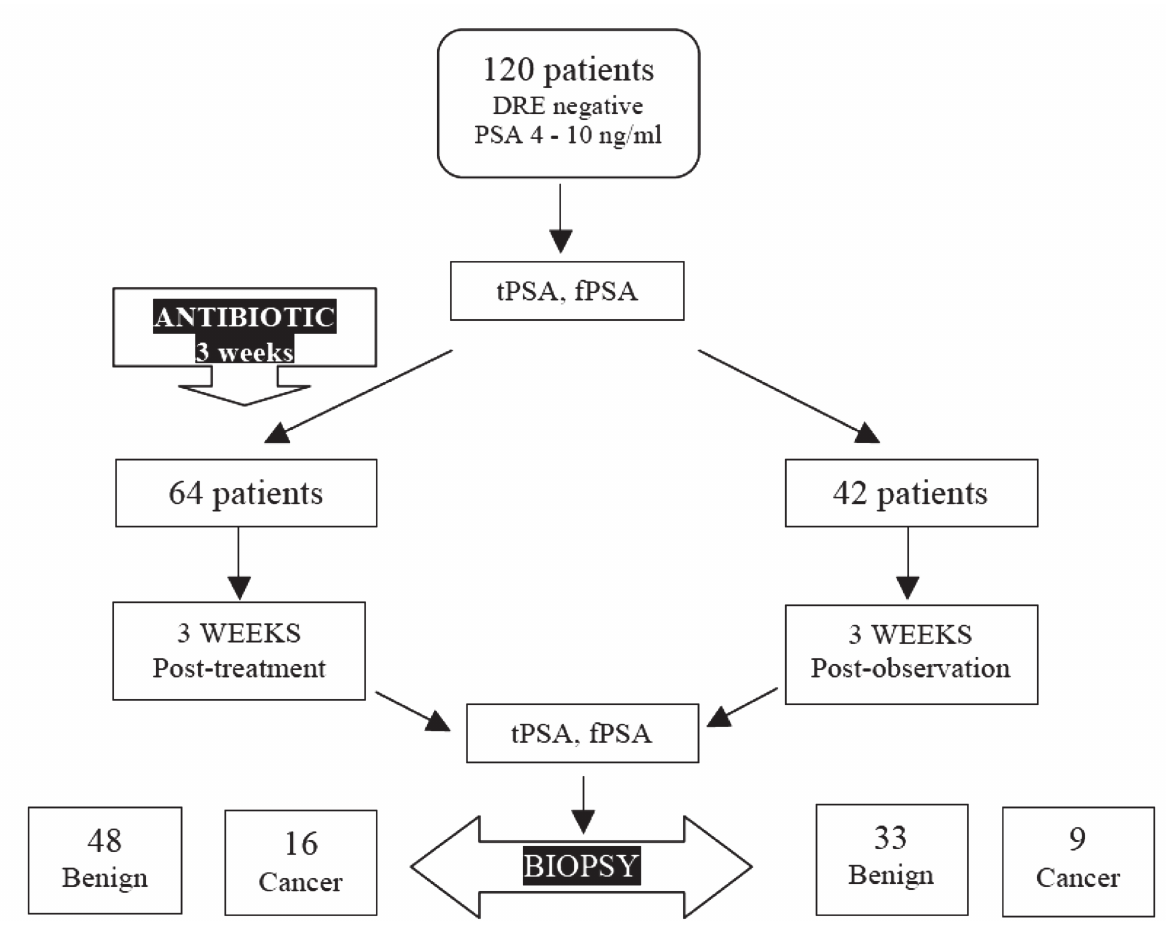
Figure 1 - Study design and data organogram. DRE: digital rectal examination; tPSA: PSA total; fPSA: PSA